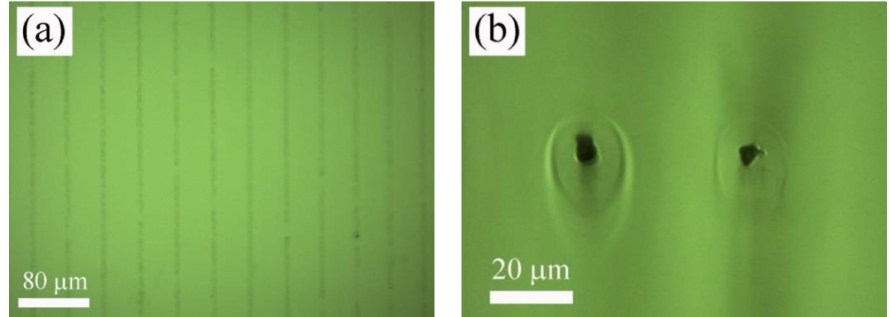
Figure 3. Top-view ( a ) and cross-section-view ( b ) microscope images in bright field mode of the sample processed with the laser oscillator at 750 nm, with 40 µ m inter-line spacing, 1.5 nJ pulse energy, and 0.050 mm /